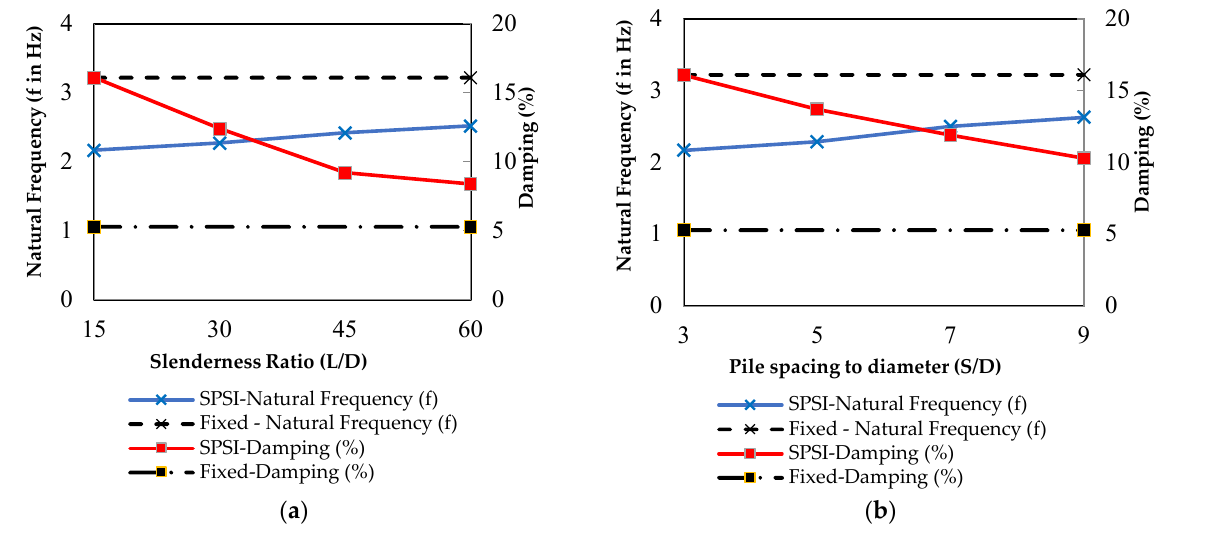
Figure 8. Comparison of the natural frequency and damping of an SPSI system and fixed-base structure: ( a ) a varying slenderness ratio for the models with S/D = 3, and ( b ) the varying spacing of piles for the models, with L/D = 15.